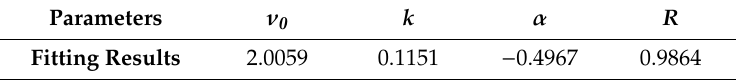
Table 1. Fitting results of crosslinking density exponential model.